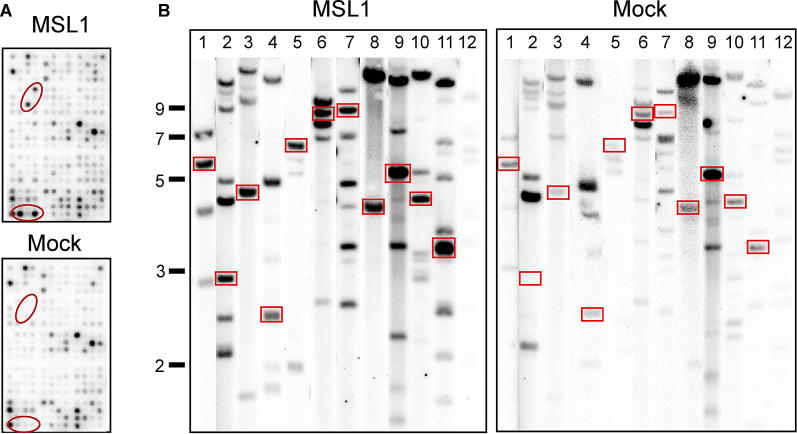
Identification of New DCC Binding Fragments Using Chromatin IP(A) Subsection of genomic P1 phage clone filter, showing 120 clones out of a total of 9,216, hybridized with MSL1 ChIP probe (upper panel), then stripped and re-hybridized to the mock IP control (lower panel). Two examples of clones showing MSL1 enrichment chosen for further analysis are indicated by red circles. Note that clones are always spotted in duplicate on the membrane.(B) Southern blots of digested P1 clone DNA hybridized to MSL1 ChIP (left panel) or mock ChIP (right panel). Red boxes highlight the bands enriched in the MSL1 ChIP chosen for cloning, known as DBF1–DBF14. Size in kilobases is indicated to the left of the figure. Lane order and restriction digests are as follows: Lane 1, DBF1 (BglII); 2, DBF3 (XhoI); 3, DBF5 (XhoI); 4, DBF6 (ApaLI); 5, DBF7 (BamHI); 6, DBF9 (XhoI); 7, DBF10 (EcoRI); 8, DBF11 (ApaLI); 9, DBF12 (EcoRI); 10, DBF13 (EcoRI); 11, DBF14 (EcoRI); and 12, autosomal DNA control P1 clone (EcoRI). Note that clones DBF2, DBF4, and DBF8 (false positives) have been omitted from this figure. P1 phage clone identifiers are listed in the Materials and Methods section.